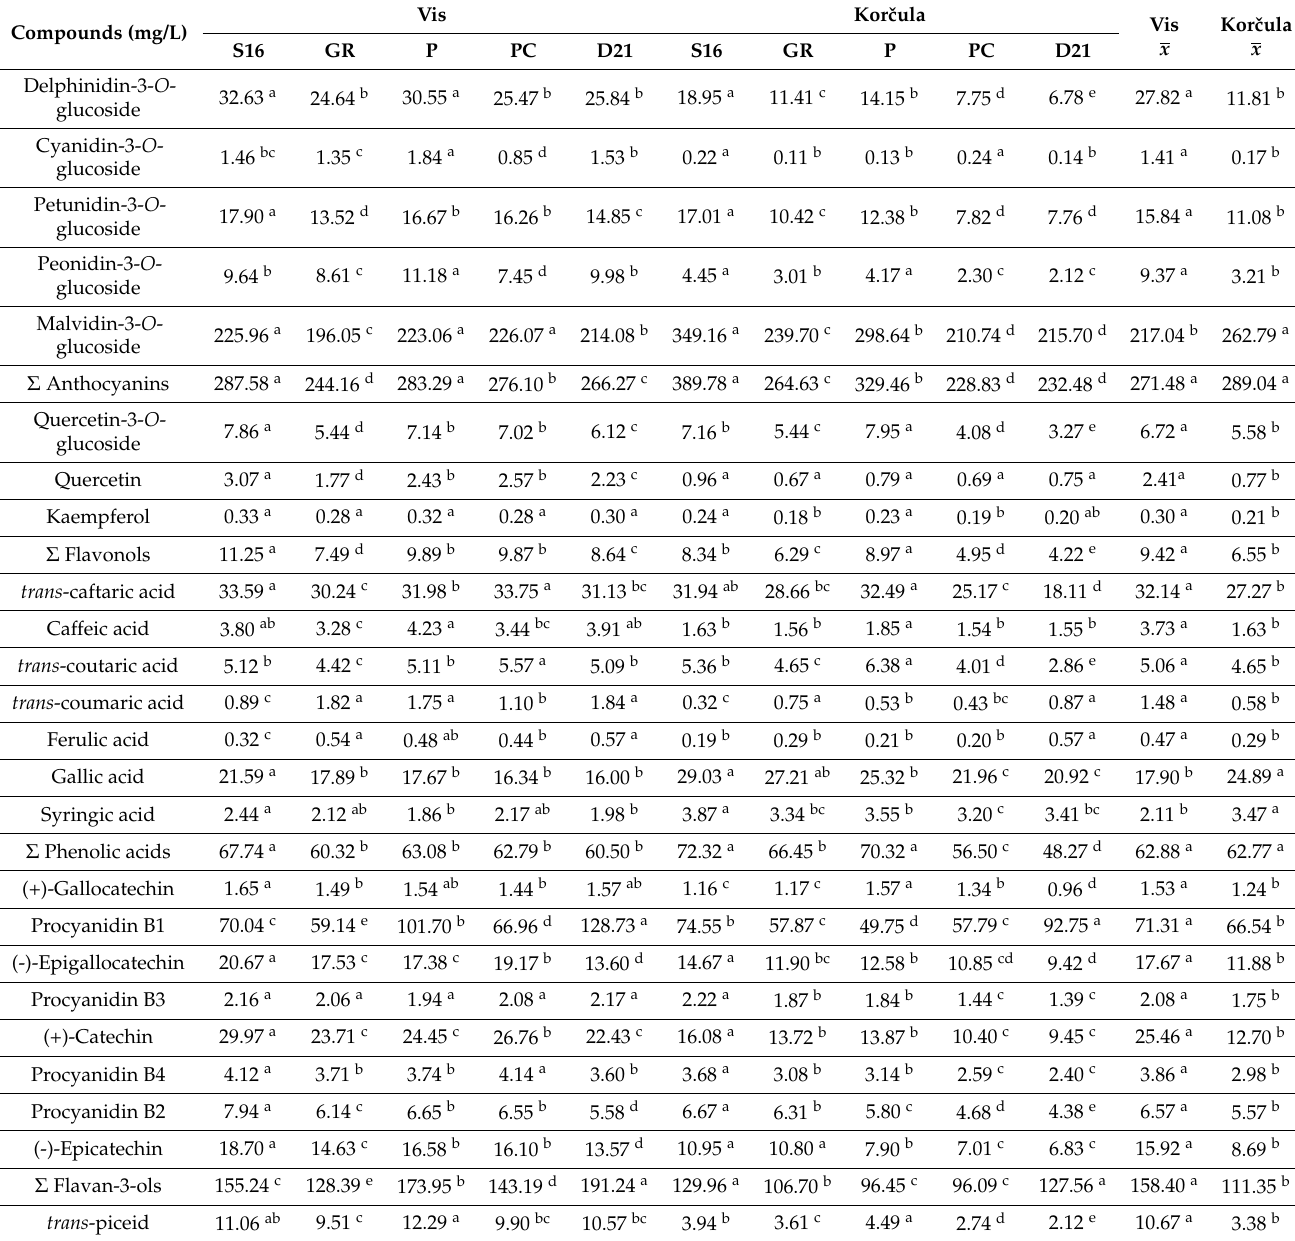
Table 4. Phenolic profile of Plavac mali